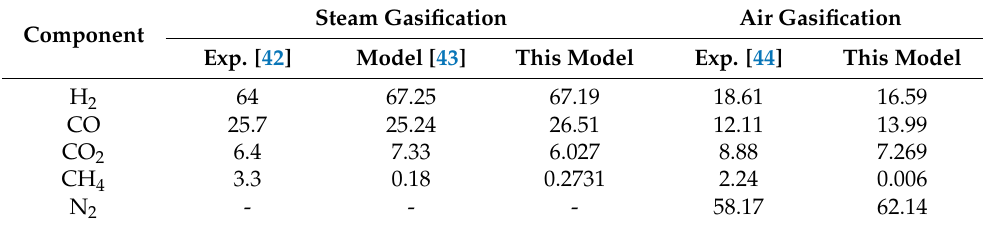
Table 2. Comparing the syngas composition for steam and air